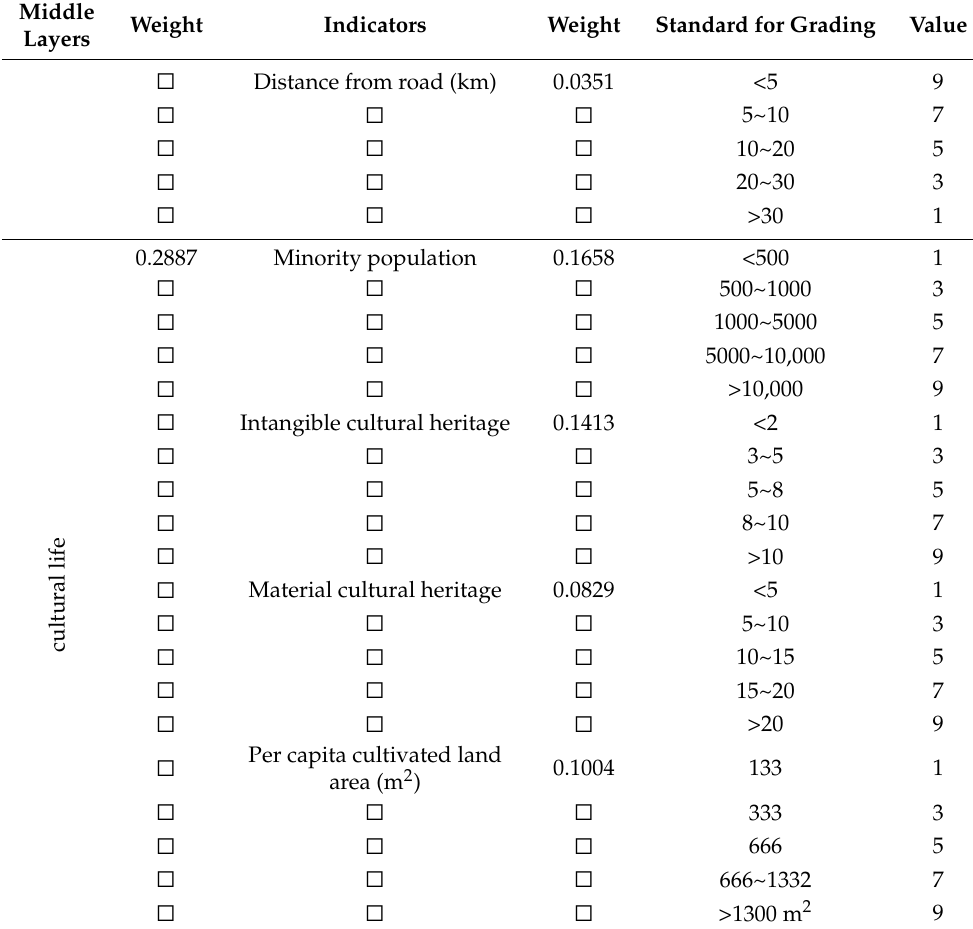
Table 3. Cont. Table 3. Evaluation indicator table of the suitability of spatial distribution of ethnic minority villages in Fujian Province. Table 3. Evaluation indicator table of the suitability of spatial distribution of ethnic minority villages Table 3. Evaluation indicator table of the suitability of spatial distribution of ethnic minority villages Table 3. Evaluation indicator table of the suitability of spatial distribution of ethnic minority villages in Fujian Province. in Fujian Province. in Fujian Province. Table 3. Evaluation indicator table of the suitability of spatial distribution of ethnic minority villages Table 3. Evaluation indicator table of the suitability of spatial distribution of ethnic minority villages Table 3. Evaluation indicator table of the suitability of spatial distribution of ethnic minority villages in Fujian Province. in Fujian Province. in Fujian Province. Table 3. Evaluation indicator table of the suitability of spatial distribution of ethnic minority villages Table 3. Evaluation indicator table of the suitability of spatial distribution of ethnic minority villages Table 3. Evaluation indicator table of the suitability of spatial distribution of ethnic minority villages in Fujian Province. in Fujian Province. in Fujian Province. Table 3. Evaluation indicator table of the suitability of spatial distribution of ethnic minority villages Table 3. Evaluation indicator table of the suitability of spatial distribution of ethnic minority villages Table 3. Evaluation indicator table of the suitability of spatial distribution of ethnic minority villages in Fujian Province. in Fujian Province. in Fujian Province. Table 3. Evaluation indicator table of the suitability of spatial distribution of ethnic minority villages Table 3. Evaluation indicator table of the suitability of spatial distribution of ethnic minority villages Table 3. Evaluation indicator table of the suitability of spatial distribution of ethnic minority villages in Fujian Province. in Fujian Province. in Fujian Province. Table 3. Evaluation indicator table of the suitability of spatial distribution of ethnic minority villages Table 3. Evaluation indicator table of the suitability of spatial distribution of ethnic minority villages Table 3. Evaluation indicator table of the suitability of spatial distribution of ethnic minority villages in Fujian Province. in Fujian Province. in Fujian Province. Table 3. Evaluation indicator table of the suitability of spatial distribution of ethnic minority villages Table 3. Evaluation indicator table of the suitability of spatial distribution of ethnic minority villages Table 3. Evaluation indicator table of the suitability of spatial distribution of ethnic minority villages in Fujian Province. in Fujian Province. in Fujian Province. Table 3. Evaluation indicator table of the suitability of spatial distribution of ethnic minority villages Table 3. Evaluation indicator table of the suitability of spatial distribution of ethnic minority villages Table 3. Evaluation indicator table of the suitability of spatial distribution of ethnic minority villages in Fujian Province. in Fujian Province. in Fujian Province. Table 3. Evaluation indicator table of the suitability of spatial distribution of ethnic minority villages in Fujian Province. Table 3. Evaluation indicator table of the suitability of spatial distribution of ethnic minority villages Table 3. Evaluation indicator table of the suitability of spatial distribution of ethnic minority villages Table 3. Evaluation indicator table of the suitability of spatial distribution of ethnic minority villages ☐ in Fujian Province. in Fujian Province. in Fujian Province. Table 3. Evaluation indicator table of the suitability of spatial distribution of ethnic minority villages Table 3. Evaluation indicator table of the suitability of spatial distribution of ethnic minority villages Table 3. Evaluation indicator table of the suitability of spatial distribution of ethnic minority villages ☐ in Fujian Province. in Fujian Province. in Fujian Province. Table 3. Evaluation indicator table of the suitability of spatial distribution of ethnic minority villages Table 3. Evaluation indicator table of the suitability of spatial distribution of ethnic minority villages Table 3. Evaluation indicator table of the suitability of spatial distribution of ethnic minority villages ☐ in Fujian Province. in Fujian Province. in Fujian Province. Table 3. Evaluation indicator table of the suitability of spatial distribution of ethnic minority villages Table 3. Evaluation indicator table of the suitability of spatial distribution of ethnic minority villages Table 3. Evaluation indicator table of the suitability of spatial distribution of ethnic minority villages in Fujian Province. in Fujian Province. in Fujian Province. Table 3. Evaluation indicator table of the suitability of spatial distribution of ethnic minority villages in Fujian Province. Table 3. Evaluation indicator table of the suitability of spatial distribution of ethnic minority villages Table 3. Evaluation indicator table of the suitability of spatial distribution of ethnic minority villages Table 3. Evaluation indicator table of the suitability of spatial distribution of ethnic minority villages Middle Layers Weight in Fujian Province. in Fujian Province. in Fujian Province. Table 3. Evaluation indicator table of the suitability of spatial distribution of ethnic minority villages Table 3. Evaluation indicator table of the suitability of spatial distribution of ethnic minority villages Table 3. Evaluation indicator table of the suitability of spatial distribution of ethnic minority villages in Fujian Province. in Fujian Province. in Fujian Province. Table 3. Evaluation indicator table of the suitability of spatial distribution of ethnic minority villages Table 3. Evaluation indicator table of the suitability of spatial distribution of ethnic minority villages in Fujian Province. in Fujian Province. Table 3. Evaluation indicator table of the suitability of spatial distribution of ethnic minority villages Table 3. Evaluation indicator table of the suitability of spatial distribution of ethnic minority villages Table 3. Evaluation indicator table of the suitability of spatial distribution of ethnic minority villages in Fujian Province. in Fujian Province. in Fujian Province. Table 3. Evaluation indicator table of the suitability of spatial distribution of ethnic minority villages in Fujian Province. Table 3. Evaluation indicator table of the suitability of spatial distribution of ethnic minority villages Table 3. Evaluation indicator table of the suitability of spatial distribution of ethnic minority villages Table 3. Evaluation indicator table of the suitability of spatial distribution of ethnic minority villages in Fujian Province. in Fujian Province. in Fujian Province. Table 3. Evaluation indicator table of the suitability of spatial distribution of ethnic minority villages Table 3. Evaluation indicator table of the suitability of spatial distribution of ethnic minority villages Table 3. Evaluation indicator table of the suitability of spatial distribution of ethnic minority villages in Fujian Province. in Fujian Province. in Fujian Province. Table 3. Evaluation indicator table of the suitability of spatial distribution of ethnic minority villages Table 3. Evaluation indicator table of the suitability of spatial distribution of ethnic minority villages Table 3. Evaluation indicator table of the suitability of spatial distribution of ethnic minority villages in Fujian Province. in Fujian Province. in Fujian Province. Table 3. Evaluation indicator table of the suitability of spatial distribution of ethnic minority villages Table 3. Evaluation indicator table of the suitability of spatial distribution of ethnic minority villages Table 3. Evaluation indicator table of the suitability of spatial distribution of ethnic minority villages in Fujian Province. in Fujian Province. in Fujian